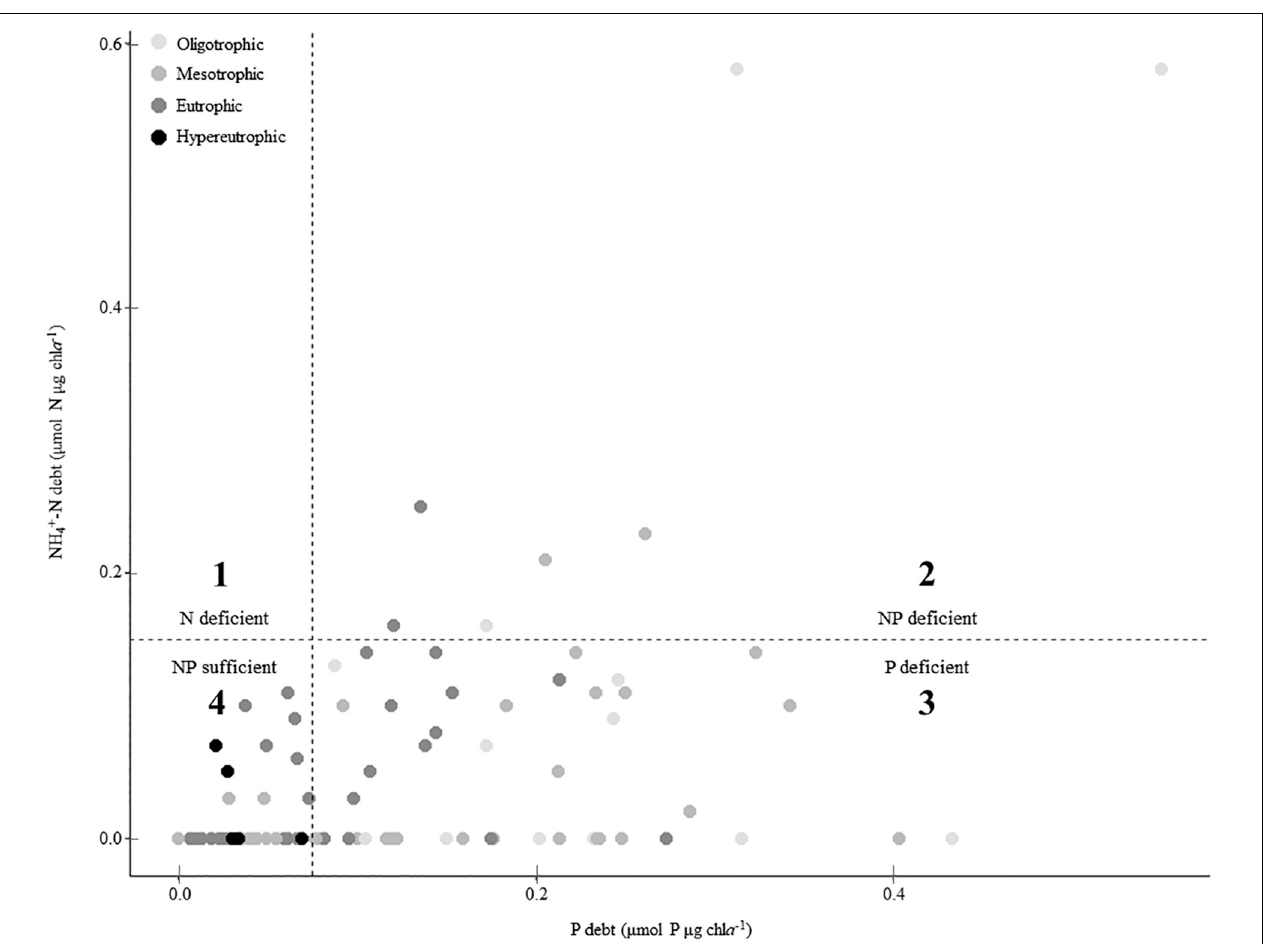
FIGURE 6 | Summary of nutrient deficiency across the trophic gradient according to phosphorus (P) and ammonium (NH 4 + ) debts. Dashed lines indicate deficiency thresholds for P and NH 4 + -debts ( Table 2 ). Values above these lines suggest deficiency, thus quadrants 1, 3, and 2 represent N-only deficiency, P-only deficiency, and NP co-deficiency, respectively. Quadrant 4 represents nutrient sufficiency in both P and N.